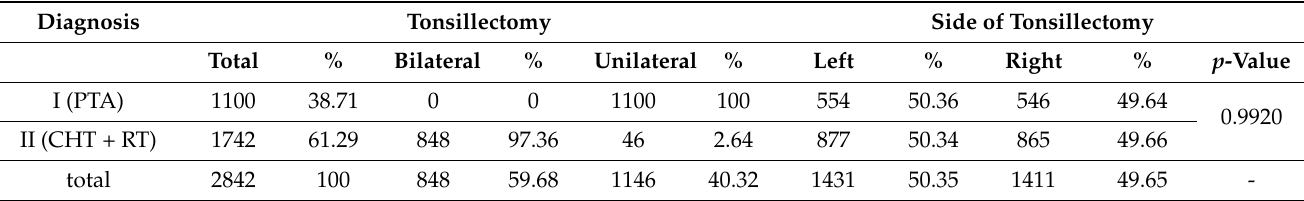
Table 2. Type of surgery in the patient